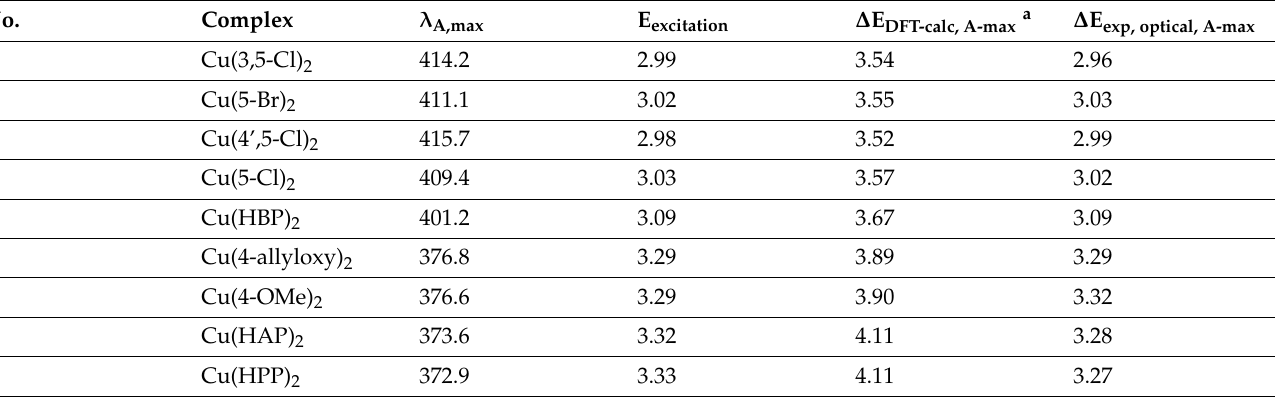
Figure 10. Relationship between experimentally determined optical band gap from the maximum absorbance ( Δ E opt,A-max,exp ) and ( a ) the B3LYP/6-311G(d,p)/def2-TZVPP calculated band gap between the main MOs involved in the electronic transition ( Δ E opt,A-max,calc , average value of E gap as shown in Figure 4 for ( 5 )), ( b ) the excitation energy of the λ A,max peak (Data in Table 5). Table 5. B3LYP/6-311G(d,p)/def2-TZVPP E gap and experimentally determined E gap (from UV-vis absorbance maximum wavelength λ A,max ).